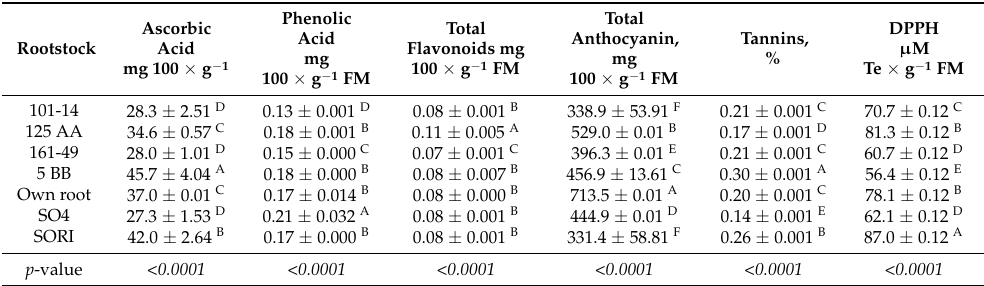
Table 2. Effect of the rootstock on the content of biologically active compounds and antioxidant activity of Regent grapevine